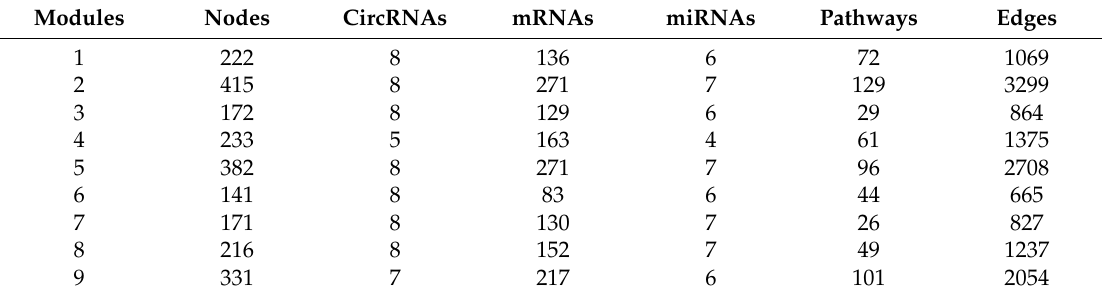
Table 2. Summary of 9 circRNA modules, including 2703 genes, 80 circRNAs, 63 miRNAs and 1318